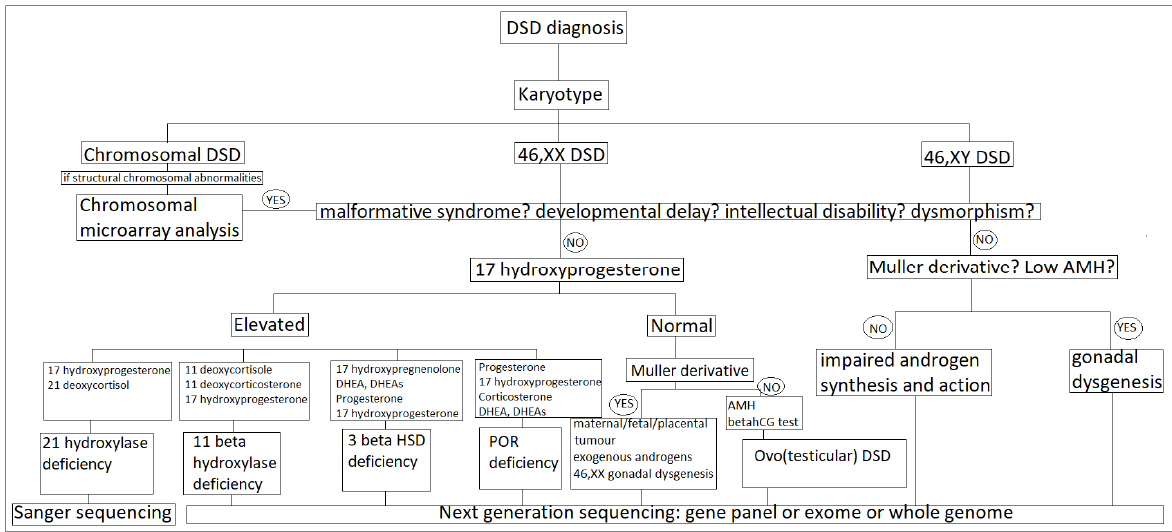
Figure 8. Genetic testing algorithm in DSD [51].